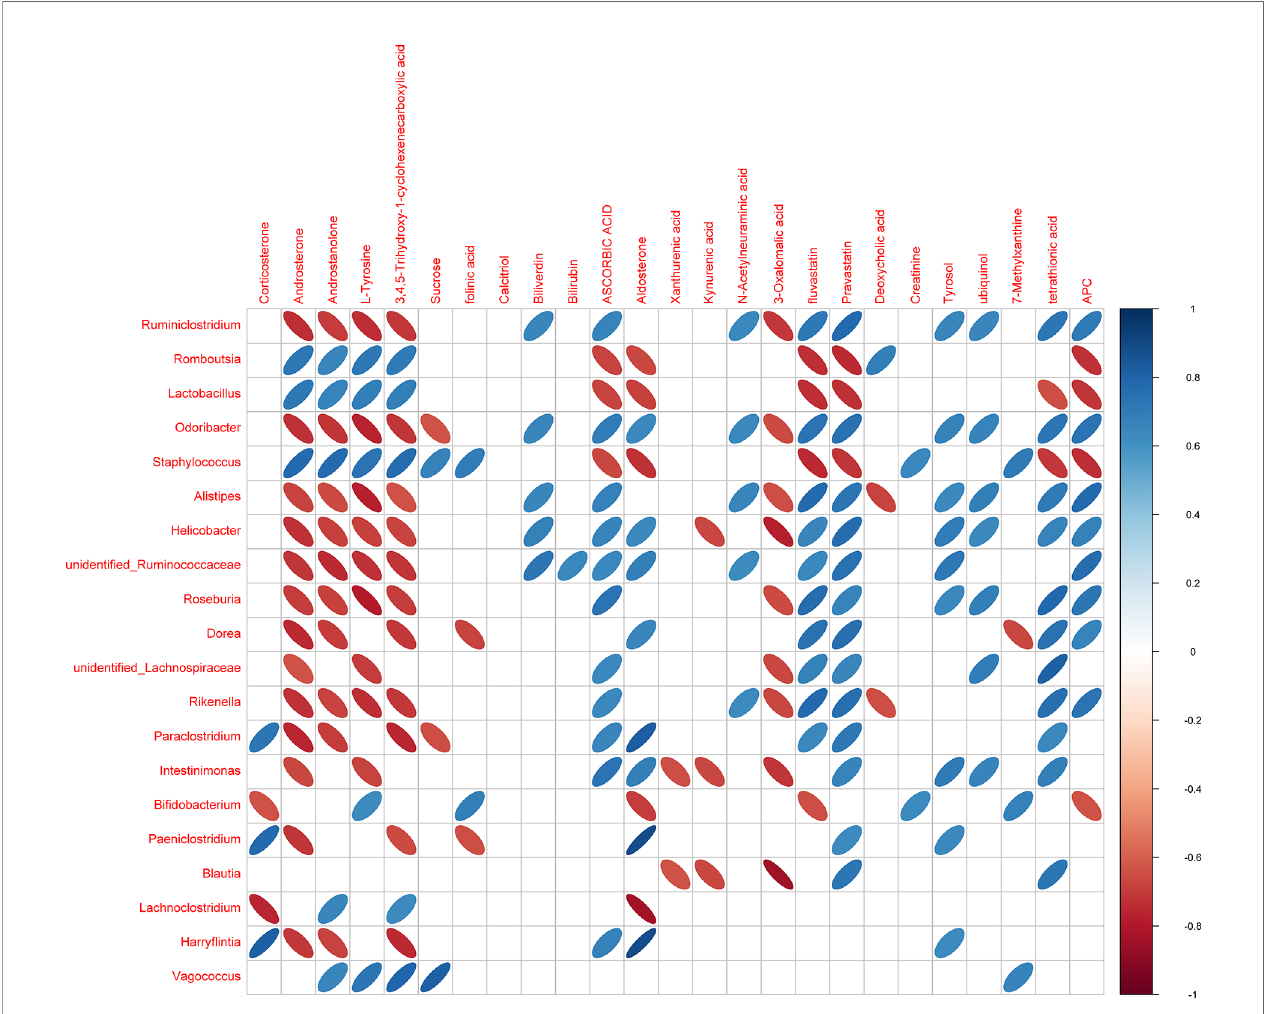
FIGURE 9 | Heatmap of Spearman ’ s correlation between the microbiome and metabolites. The abscissa denotes the top-20 different metabolites and the ordinate is the top-10 different microbiomes at generic level in the HTPs and DSS groups. The color represents a signi fi cant correlation ( P ≤ 0.05), and the color scale denotes Spearman ’ s correlation from blue (positive correlation) to red (negative correlation) ( n =